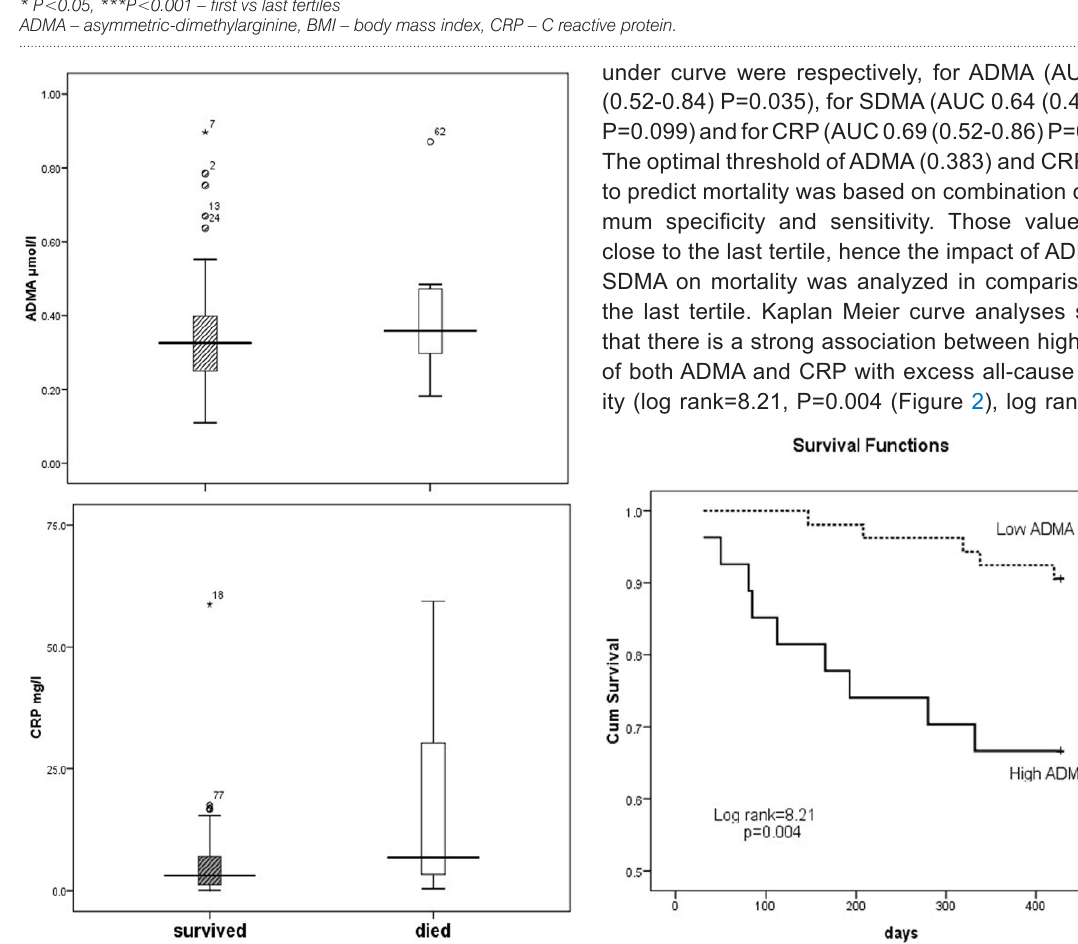
Figure 1. Plasma ADMA and CRP concentration in patients with end stage renal disease (ESRD) according to their survival after a 14 month follow-up period.